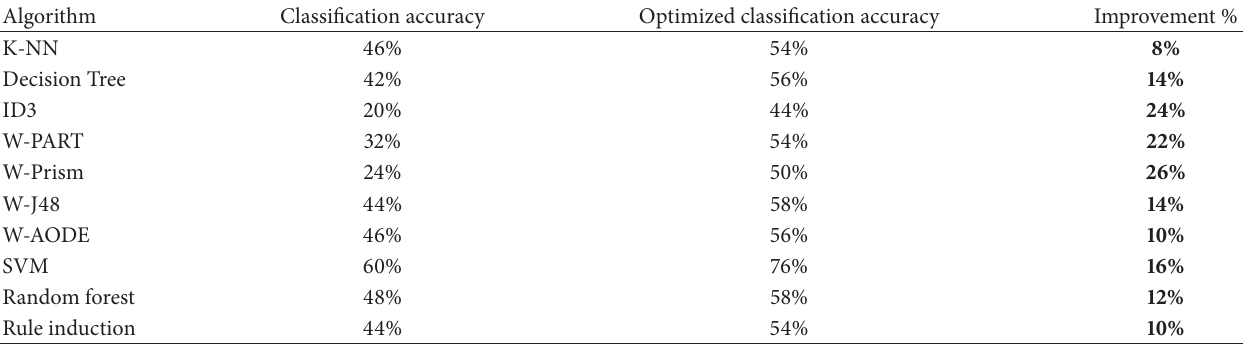
Table 11: Results of educational dataset: comparison of optimized classification accuracy using GMC model with simple classification using different